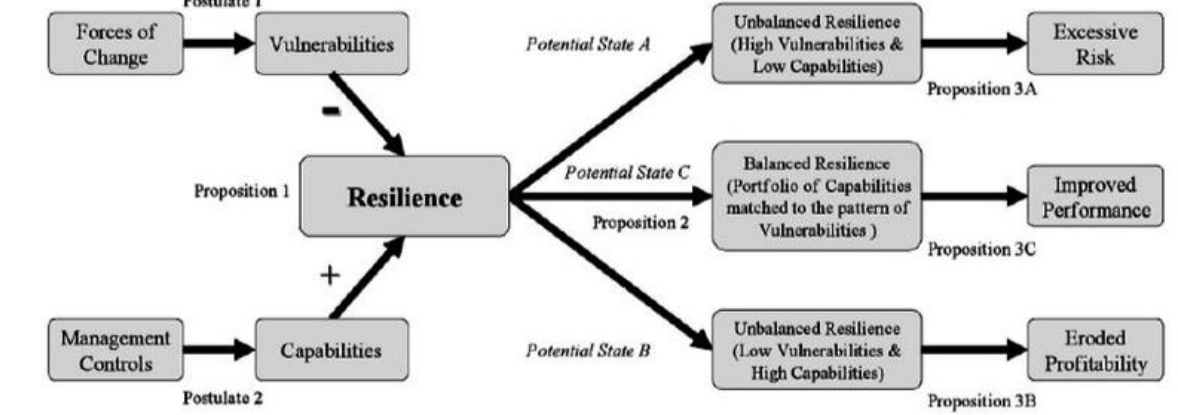
Figure 4. The State-Based Framework of Supply Chain